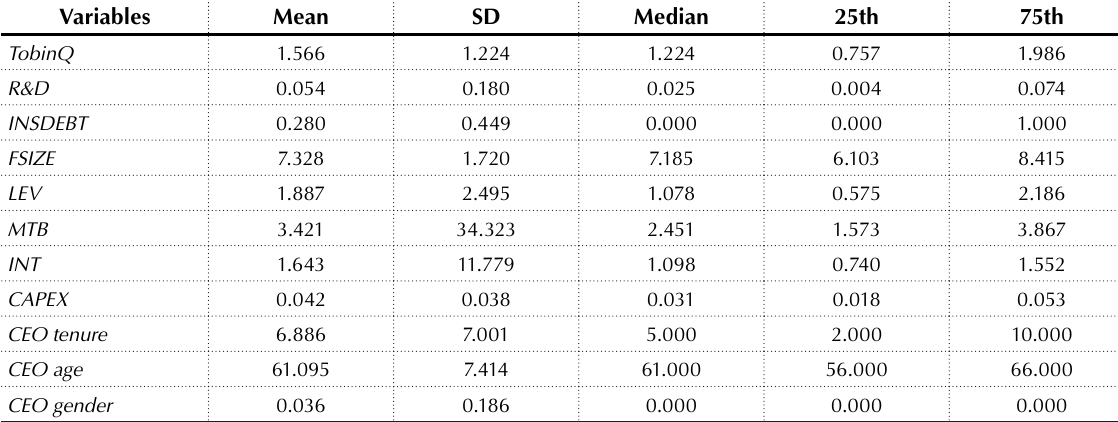
Table 1. Summary